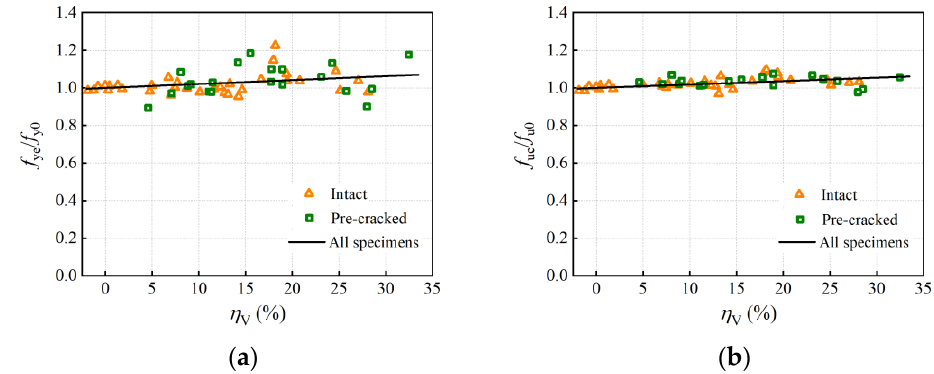
Figure 11. Normalized effective strength: ( a ) yield strength; ( b ) ultimate strength.